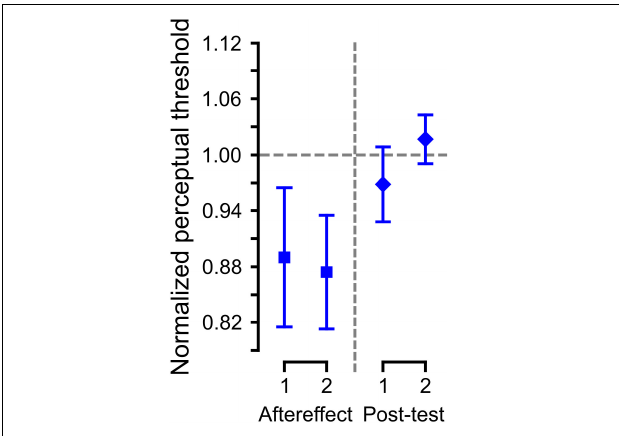
FIGURE 4 | Normalized category boundary in the Aftereffect phase and Post-test (1 week later). Error bars represent the standard error across